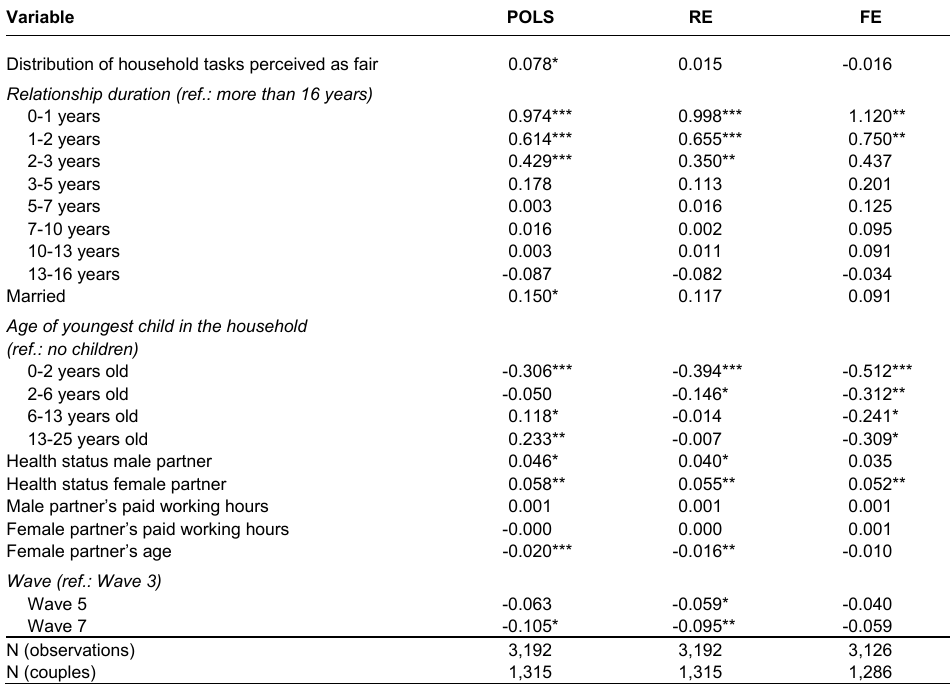
Table A.2 : Summary of pooled OLS (POLS), random (RE), and fixed effects (FE) Poisson regression analyses estimating the frequency of sexual intercourse